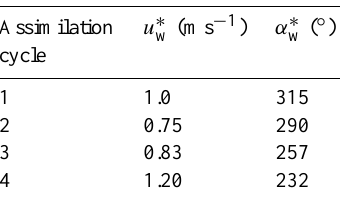
Figure 9. Schematic of the reconstruction algorithm for the FIRE- FLY initial condition. In this example, the mesh node (x N ,y N ) is −−→ ·−→ ON n A ) is positive. outside the burnt area, the inner product ( Figure 10. Schematic of the sequential SE approach for each en- semble member k = 1 , ··· ,N e , with a focus on the reconstruction of the two-dimensional progress variable c (k) posterior to analysis over the time window [ t − 1 ,t ] and prior to forecast over the time window [ t,t + 1 ] . Table 3. Time-varying true wind conditions (in terms of magnitude u ∗ w and direction angle α ∗ w ) in the OSSE anisotropic case with mul- tiple assimilation cycles, from 0 to 600s, at 150s time